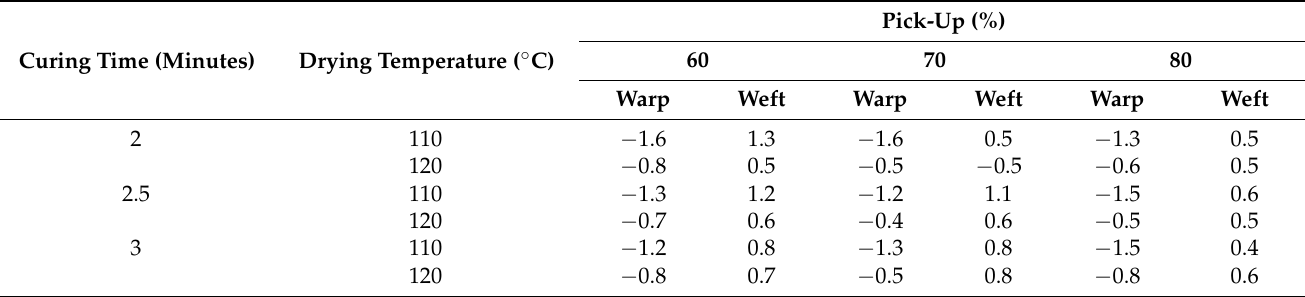
Table 8. Relationship between warp and weft in dimensional change